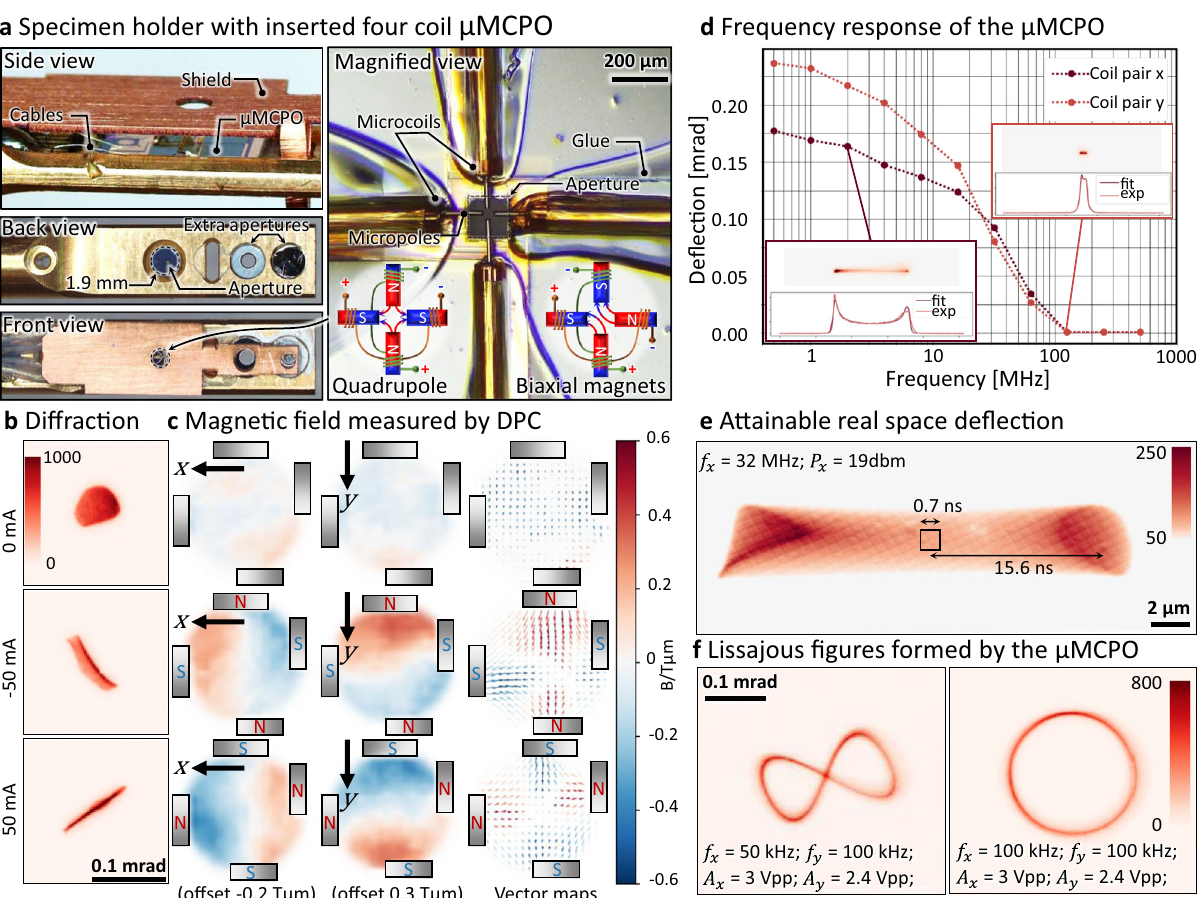
Fig. 4 Quadrupolar micro-electron beam optics. a On the left side: Aperture holder for the TEM with a custom shield ready for the insertion inside of the TEM column. On the right side: Magni fi ed view shows the cores inserted inside of the micro-coils. Depending on the con fi guration of the contacts the set- up can work as a quadrupole or as a biaxial magnet. b Beam pro fi le in the far fi eld for parallel illumination of the µ MCPOs in quadrupole con fi guration; all the coils are stimulated with a current of plus and minus 50 mA; the beam is thus focused in the xy and x ( − y ) axes, respectively. The same electrical stimulation of the sample is performed in c for the DPC measurement of the magnetic fi eld: The fi rst column depicts the x component of the magnetic fi eld, the second column depicts the y component and the third column depicts the magnetic fi eld vector. The reconstructed projected fi eld values are offset linearly by the numbers indicated in the fi gure, to correct for an additional shift of the electron beam stemming from the misalignment of the poles with respect to the micro-coils. The colors in the vector plot represent the direction of the fl ux lines, to that end, the sine of the angle multiplied by two plus 90° is color mapped. d The amplitude of a slightly anharmonic sinusoidal de fl ection of the electron beam by a device in biaxial magnet con fi guration. The unidirectional de fl ection of the beam along x and y direction (perpendicular to the respective coils) is plotted as a function of driving frequency. The insets show the beam pro fi le and the corresponding projection perpendicular to the oscillation direction used for the numerical evaluation at 2 and 128 MHz. e Attainable real space de fl ection at 32 MHz in the TEM ’ s object plane for stroboscopic experiments. f The biaxial magnet can de fl ect the electron beam in x and y direction producing Lissajous fi gures (circle and the “ ∞ ” pattern) by simultaneous excitation currents with an appropriate mutual phase and frequency